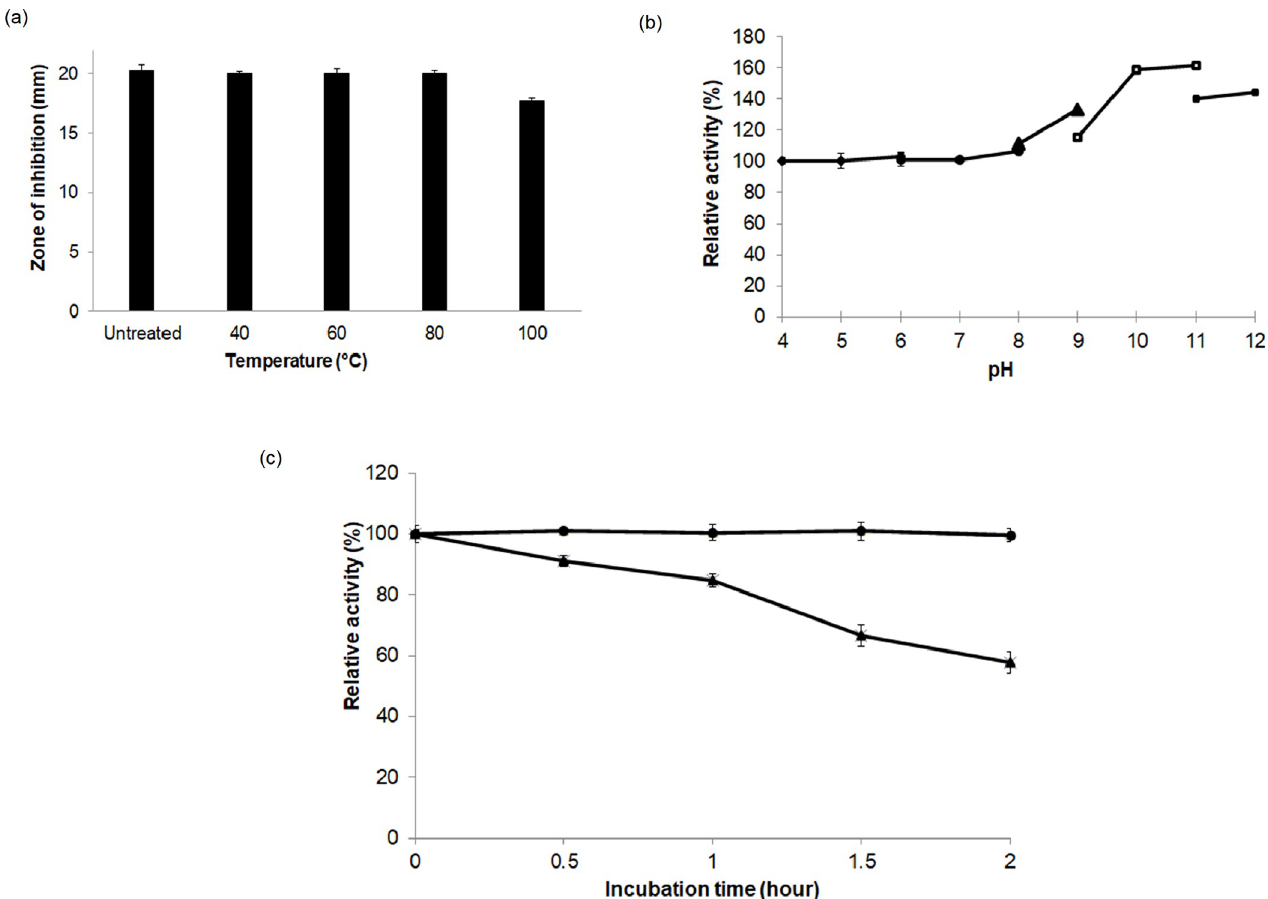
Fig 4. Physicochemical analyses of strain PD9 CFS on MRSA ATCC 33742 lawn cell plate. (a) Thermal stability of strain PD9 CFS on MRSA ATCC 33742 lawn cell plate after the heat treatment. Strain PD9 CFS was treated at 40 to 100˚C for 30 min. The inhibitory activity was tested using agar well diffusion assay. CFS at room temperature served as a control. (b) pH stability of strain PD9 CFS on MRSA ATCC 33742 lawn cell plate after 30 min of pH treatment. The buffers used for the treatments were sodium acetate (pH4-6), sodium phosphate (pH 6–8), Tris-HCI (pH 8–9), glycine-OH (pH 9–11) and sodium hydrogen phosphate (pH 11–12). The buffer alone served as a negative control. (c) Enzyme stability of strain PD9 CFS on MRSA ATCC 33742 lawn cell plate after strain PD9 CFS was treated with proteinase K for 0.5 to 2.0 h at 37˚C